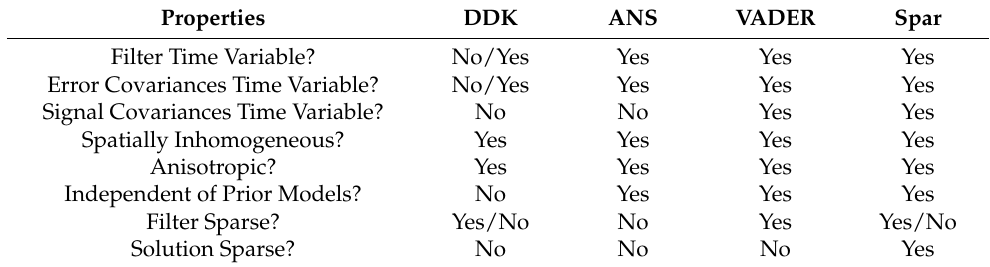
Table 1. Properties of different decorrelations filters. DR: DDK regularization [4,5]; ANS: anisotropic non-symmetric [3]; VADER: time variable decorrelation [6]; Spar: sparse DDK filter, proposed